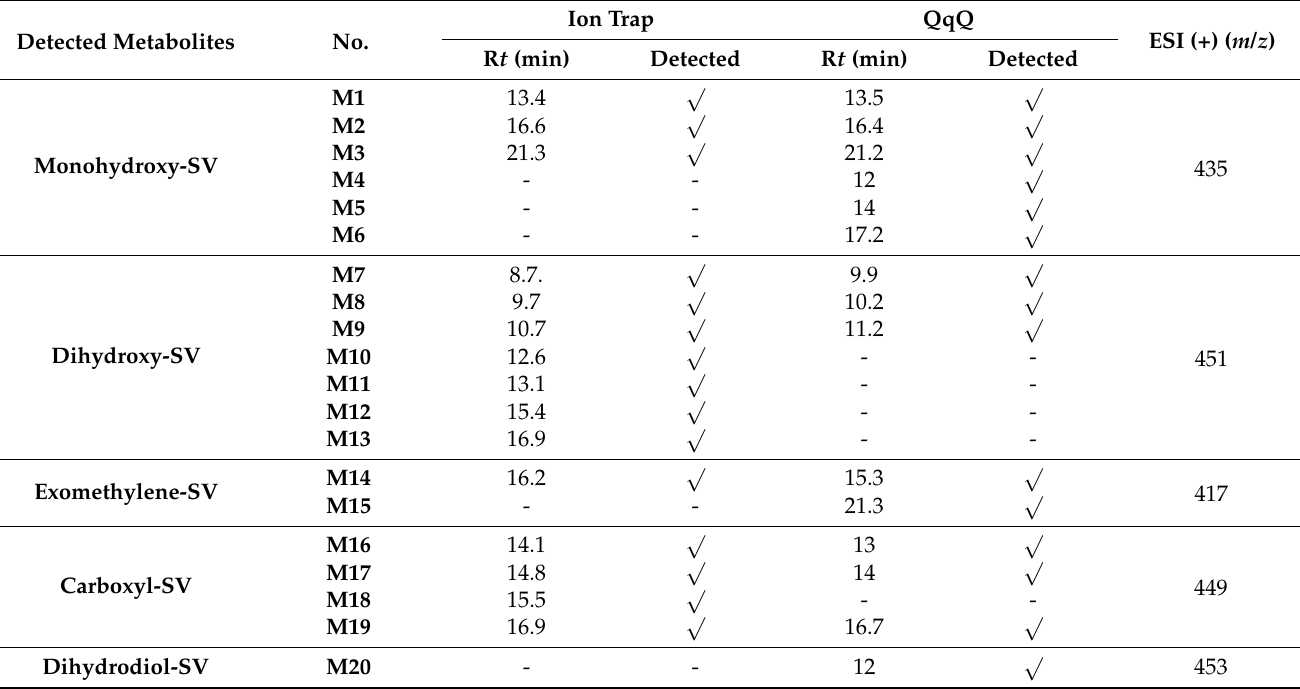
Table 1. Simvastatin metabolites identified in ion trap/QqQ MS in positive mode. Detected Metabolites